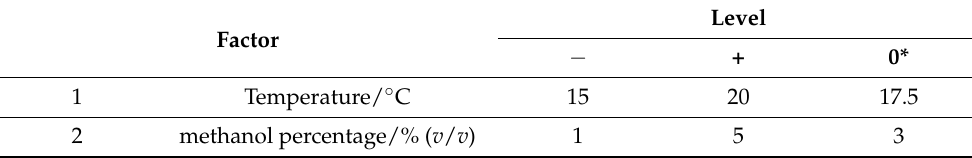
Figure 3. ( A ) Pareto, ( B ) main effects, and ( C ) desirability (methanol concentration and temperature). Graph obtained through DOE by Minitab ® software to optimize the separation by CE for Cd 2+ and Pb 2+ determination in Passifora incarnata tea.